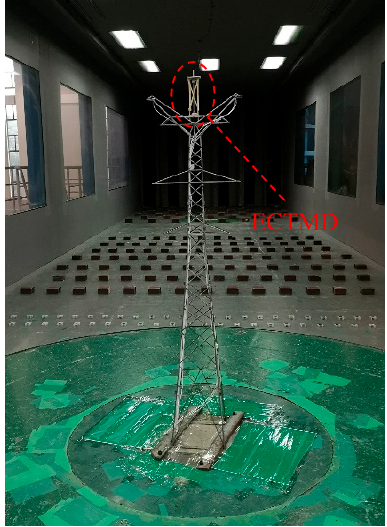
Figure 11. Experimental setup.